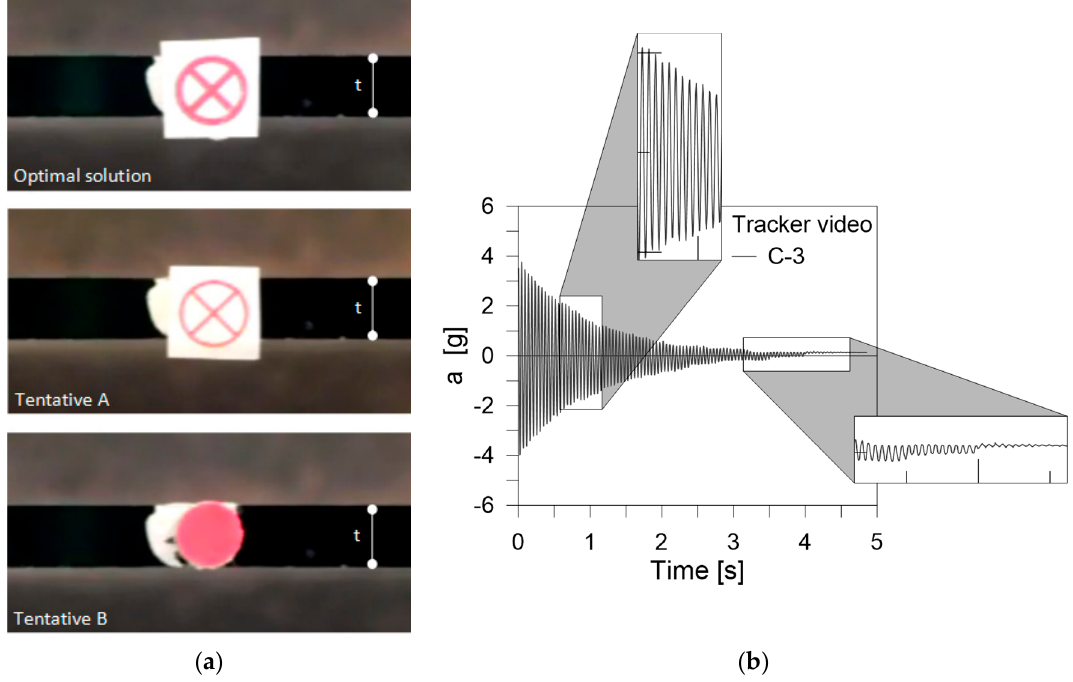
Figure 9. Experimental results from Tracker video acquisition. ( a ) Detail of the test setup and tracker features, with ( b ) typical acceleration-time history.